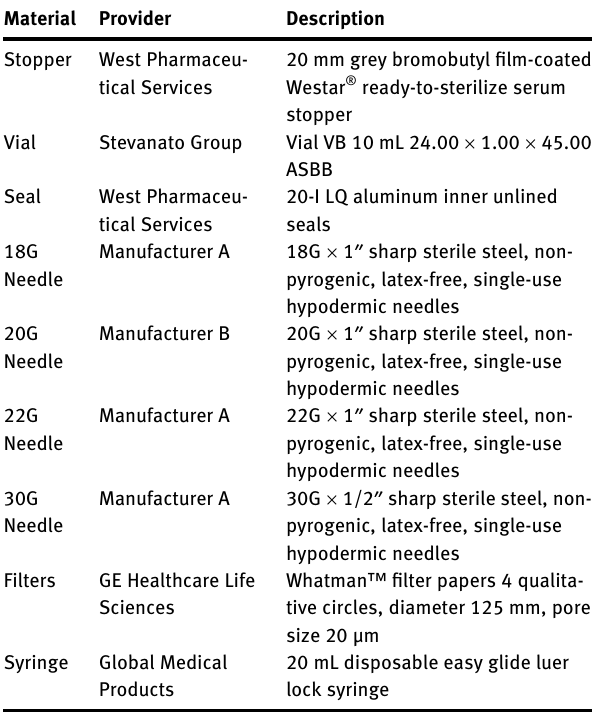
Table  : Sample materials for testing.